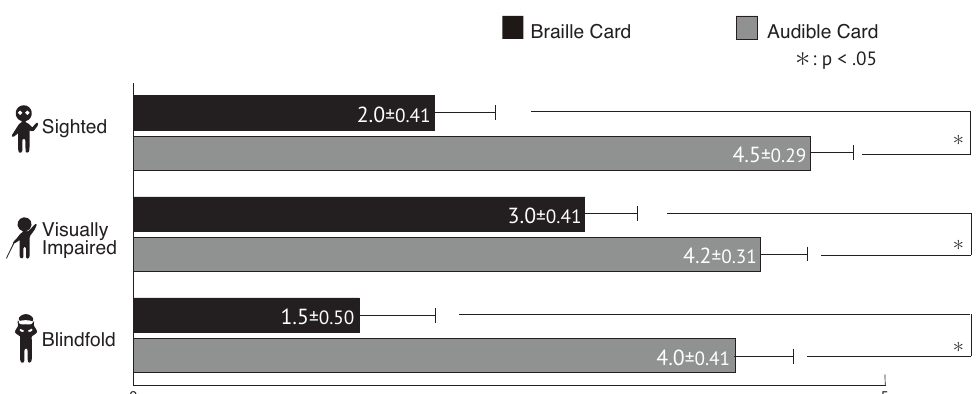
Figure 5. Results of the questionnaire. The participants of the experiment rated their enjoyment of playing Braille Karuta and “Auditory Uta-Karuta ” on a scale of 1 to